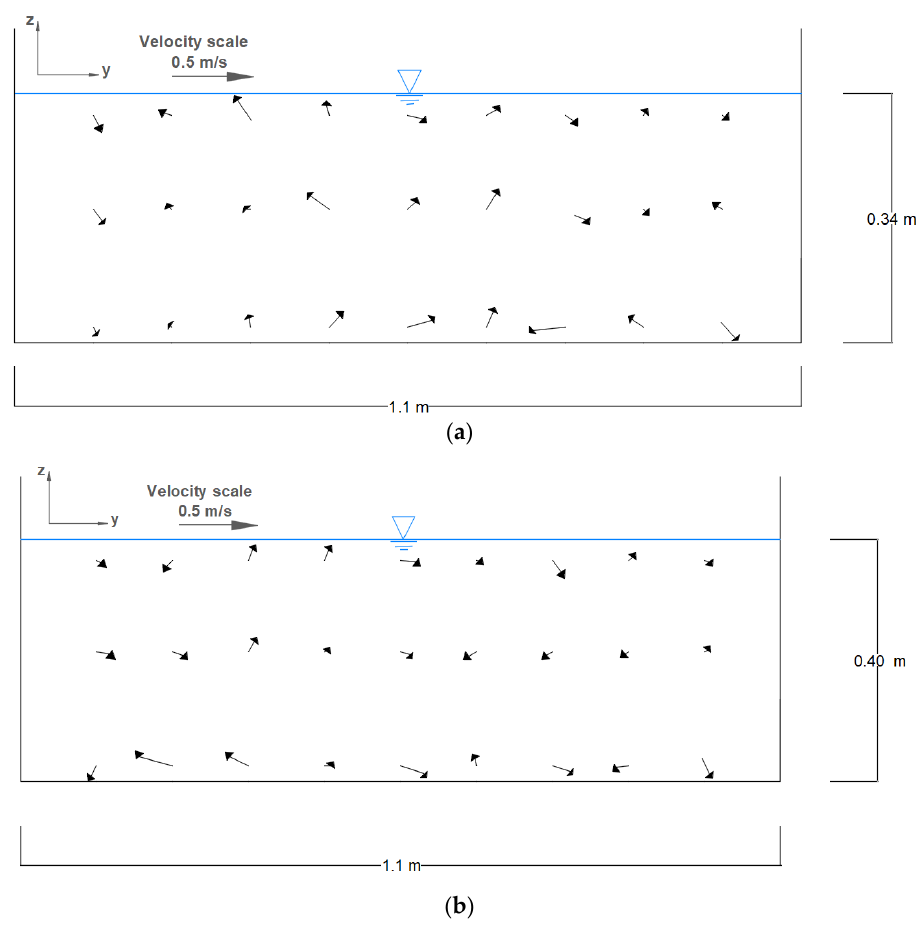
Figure 13. Spatial distribution of temporal average velocity vectors ( V yz ) in vertical section E . ( a ) Q = 0.187 m 3 /s and d/h = 0.92, ( b ) Q = 0.264 m 3 /s and d/h = 1.08.